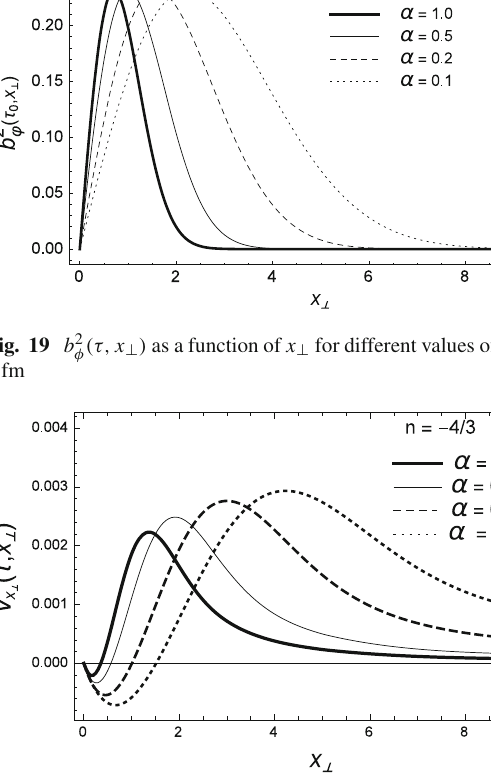
Fig. 20 v x ⊥ (τ, x ⊥ ) as a function of x ⊥ for different values of α at τ = 1 0